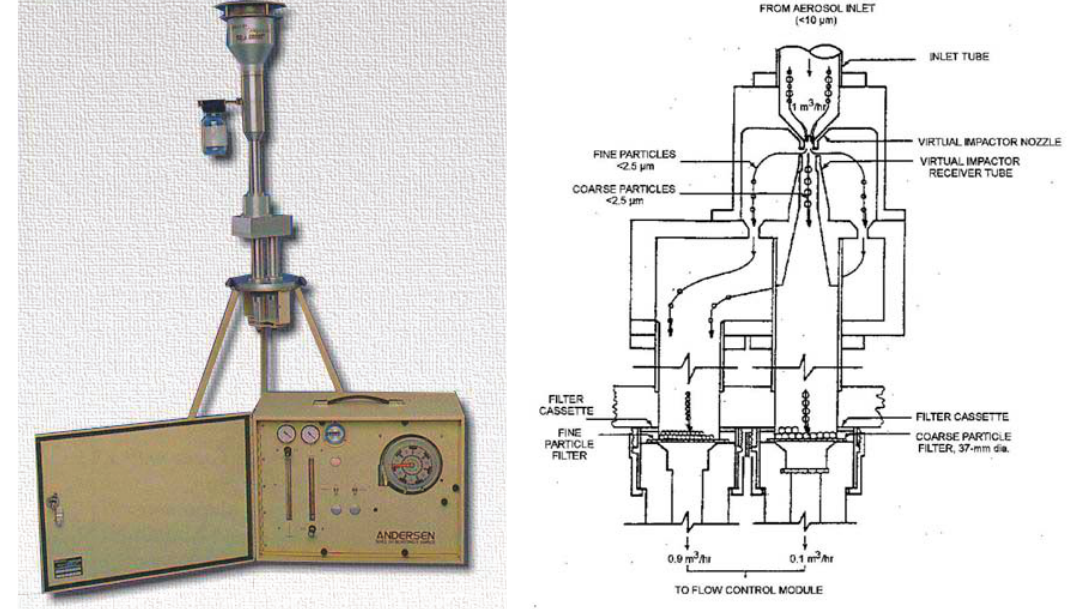
Fig. 1 The Andersen model 244 dichotomous sampler (left) and the virtual impactor (right) as implemented in the model 244 and marketed by Sierra Andersen company. The instrument was designed with an inlet flow rate of 1 m 3 /hr or 16.76 l/min ; 15 l/min ; 1.67 l/min. Of this total flow, 15 l/min was diverted into the “fine” ( < 2.5 µm) stream while 1.67 l/min went straight down the “coarse” ( > 2.5 µm) stream. Particles were collected on glass fiber filters for later analysis (Lai and Chen, 2000). Information on the instrument can be found in the Sierra Andersen instruction manual (Environmental Monitoring Systems, Laboratory, 1985). Mathematical treatment for the VI can be found in Marple and Chien